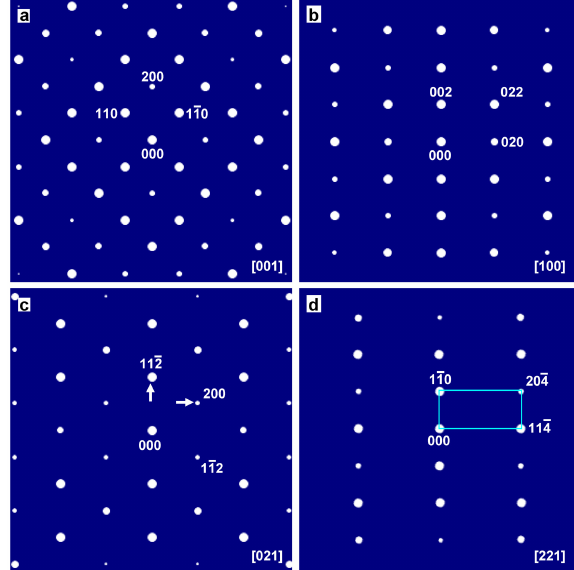
Figure 15: Calculated electron diffraction patterns of tetragonal CH 3 NH 3 PbI 3 along (a) [001], (b) [100], (c) [021], and (d) [221].